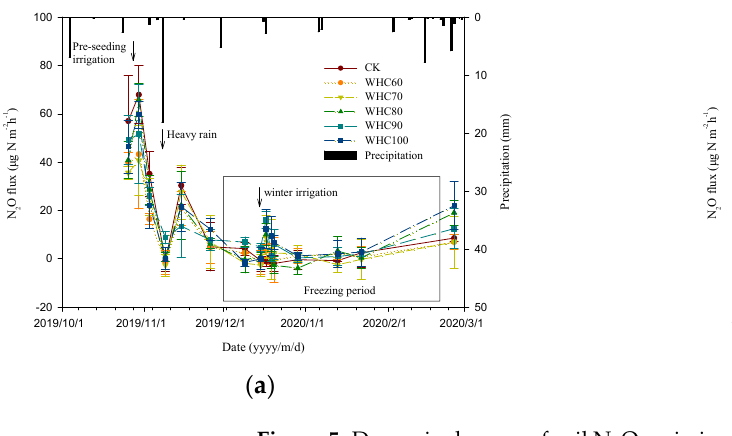
Figure 5. Dynamic changes of soil N 2 O emission in a winter wheat field ( a ) and a partial enlargement drawing ( b ). Arrows indicate the occurrences of pre-seeding irrigation (17 October 2019), heavy rain (8 November 2019) and winter irrigation (15 December 2019). The bar plot placed in the upper part is precipitation. CK refers to the treatment without winter irrigation. WHC60, WHC70, WHC80, WHC90 and WHC100 refer to the treatments with winter irrigations where soil in 0–30 cm was irrigated to 60%, 70%, 80%, 90% and 100% of the soil water holding capacity on 15 December 2019, respectively. Table 2. Soil N 2 O emission from different treatments at different sampling time. CK